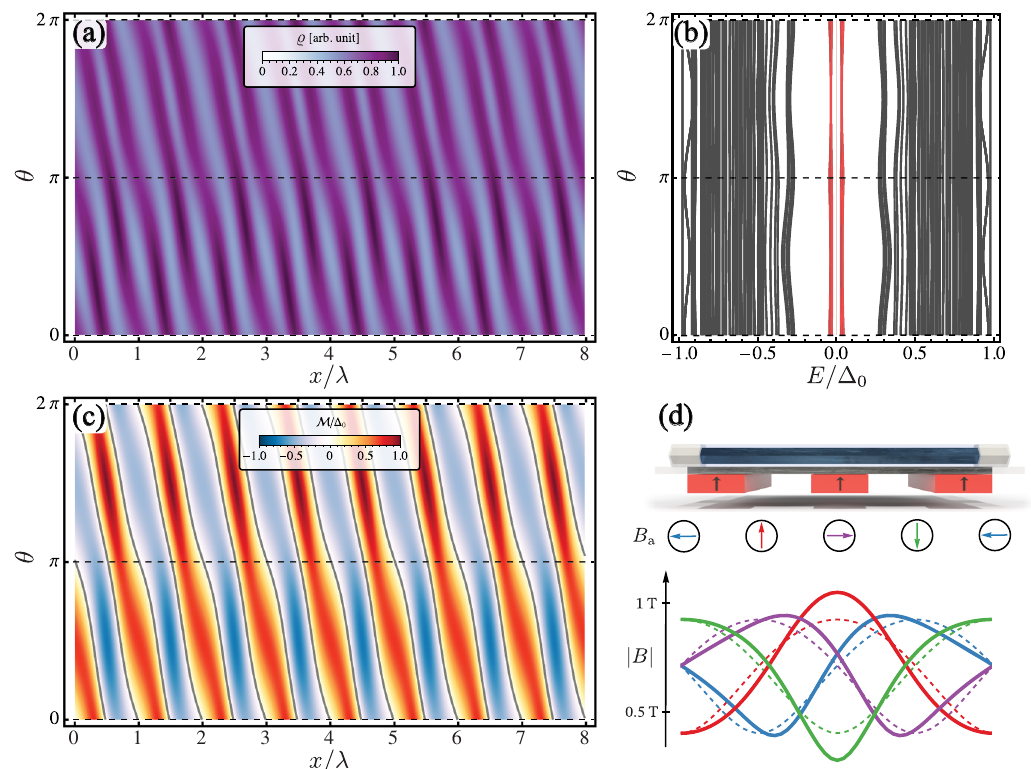
Fig. 3 Local density of states and energy spectra of a sliding Majorana lattice. Numerically calculated local density of states (LDOS) and energy spectra as a function of the applied magnetic fi eld direction, showing a sliding 1D lattice of 0D quasi-Majorana modes. a LDOS at zero energy as a function of the position x and the magnetic fi eld direction θ in the zx -plane, calculated with closed boundary conditions. 0D quasi-Majorana modes localize at the boundaries between trivial ( M > 0) and nontrivial ( M < 0) segments. As the fi eld rotates, the lattice of 0D quasi-Majorana modes slides in the x -direction. b Energy spectra E with dispersive 1D Majorana modes (highlighted) below the gap. c Local Majorana mass M as a function of the applied fi eld direction θ , with nodes at M ¼ 0 (continuous lines). d Total magnetic fi eld calculated as the superposition of the applied fi eld B a and the nanomagnets fi elds for different directions θ of the applied fi eld (continuous lines) compared with a sliding harmonic fi eld / sin ð 2 π x = λ þ θ Þ (dotted lines). Energies are in units of the superconducting gap Δ 0 , lengths are in units of the wavelength λ of the periodically-modulated fi